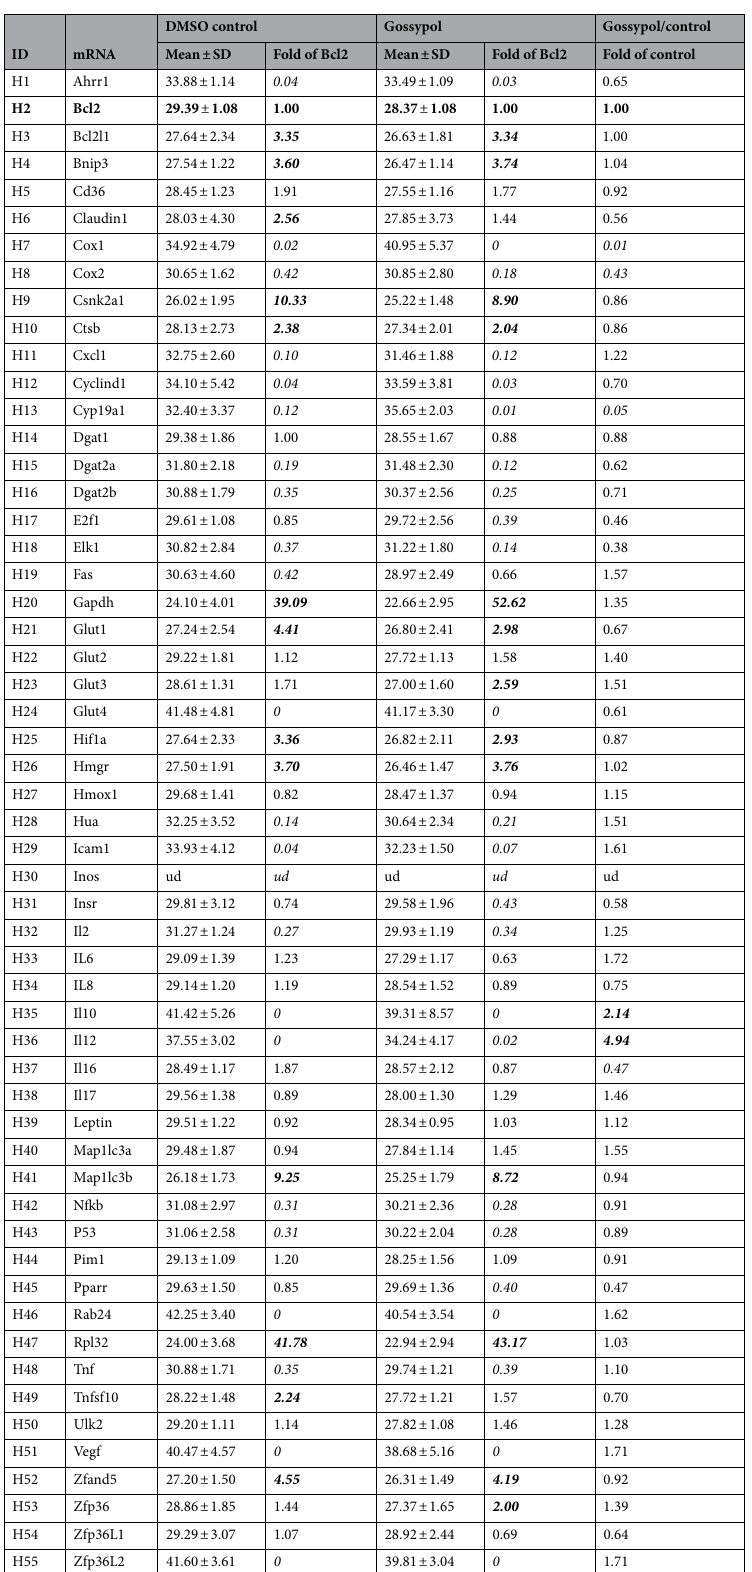
Table 2. Basal level, reference mRNA and gossypol effects on 55 gene expression. The data represent the mean and standard deviation of 24 independent samples. The fold was calculated using the mean data. ud: undetected. Bold italics: Genes with mRNA levels at least twofold of Bcl2, roughly interpreted as their expression more abundant than that of Bcl2. Italics: Genes with mRNA levels less than 50% of Bcl2, roughly interpreted as their expression less abundant than that of